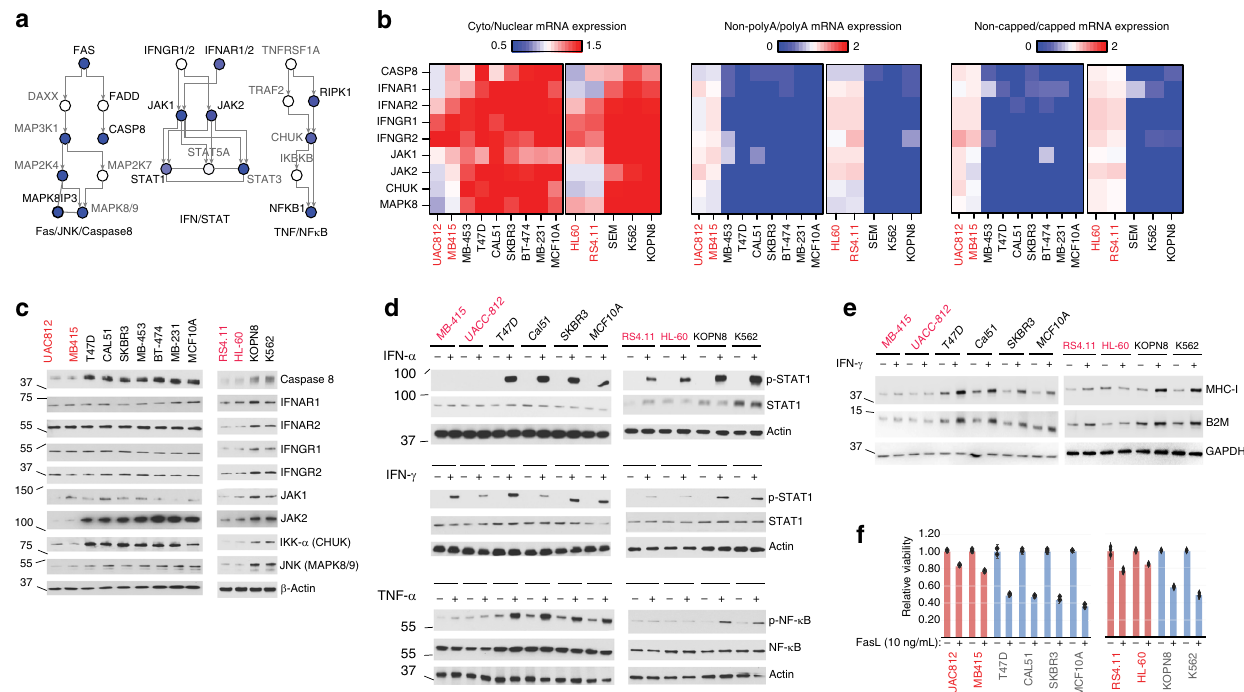
Fig. 5 TE deff impairs the expression of and signaling through the in fl ammatory response pathways and antigen presentation. a A diagram of pro- in fl ammatory response pathways relevant to anti-tumor immune surveillance. Blue nodes indicate those that are found among Class I genes. Genes that have been identi fi ed as modulators of tumor response to anti-tumor immune attack in Patel et al. 35 and Manguso et al. 34 are indicated with bold labels. b Ratios of cytoplasmic to nuclear (left), non-polyadenylated to polyadenylated (middle) and uncapped to capped mRNA levels of the key in fl ammatory response pathway genes in the indicated cell lines (qPCR). c Protein expression of the genes in b in the indicated cell lines. d TE deff and TE prof cells were stimulated with IFN- α , IFN- γ , and TNF- α for 30 min and the readout measured by immunoblotting. e Immunoblots of the expression of MHC-I and B2M proteins in the indicated cell lines at the baseline and upon stimulation with IFN- γ . f Indicated cell lines were stimulated with FasL for 24 h and the viability was measured. Error bars: standard deviation based on 3 technical